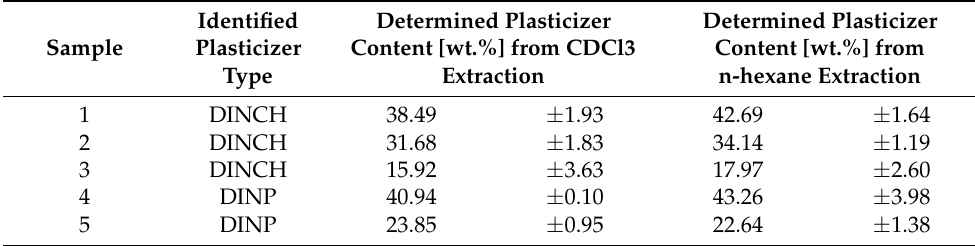
Figure 5. 1 H spectra of the unknown PVC samples 1–5 after the extraction in ( a ) CDCl 3 (residual non-deuterated solvent marked with asterisks) and ( b ) non-deuterated n-hexane. Table 2. Results of the extraction experiment. The determined concentration of the extraction solution has been converted to wt.% of plasticizer the PVC initially had, assuming all of the plasticizer had been extracted. Each extraction step was performed 3 times for each investigated PVC sheet by using samples from different positions in the